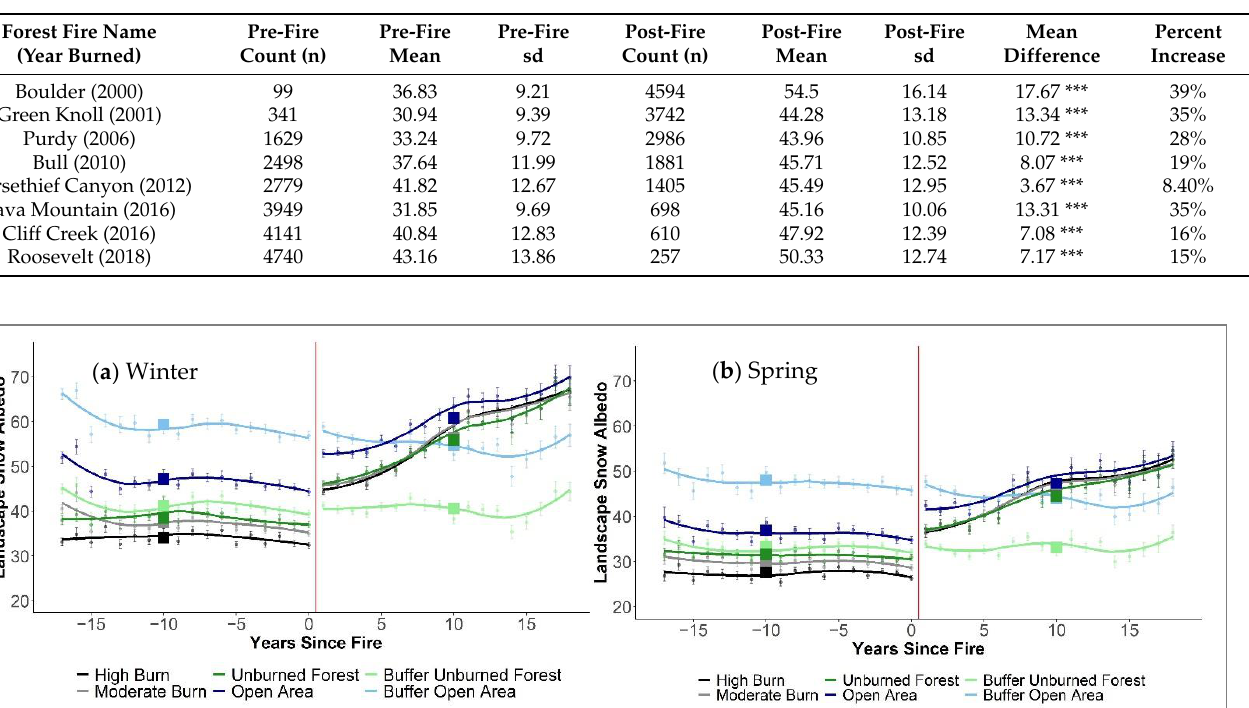
Figure 3. Pre- vs. post-fire winter and spring landscape snow albedo. ( a ) Winter and ( b ) spring pre- fire and post-fire non-normalized landscape snow albedo separated by high burn (black), moderate burn (gray), unburned forest (green), open area (blue), buffer unburned forest (light green) and buffer open area (light blue). The large squares and circles represent the pre-fire and post-fire winter and spring mean landscape snow albedo, respectively.